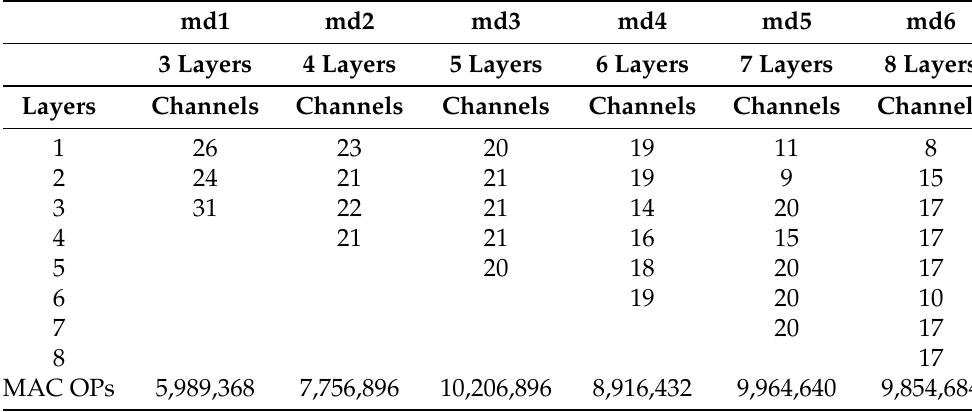
Table 5. The width configuration of optimal BNNs found by Deepbit